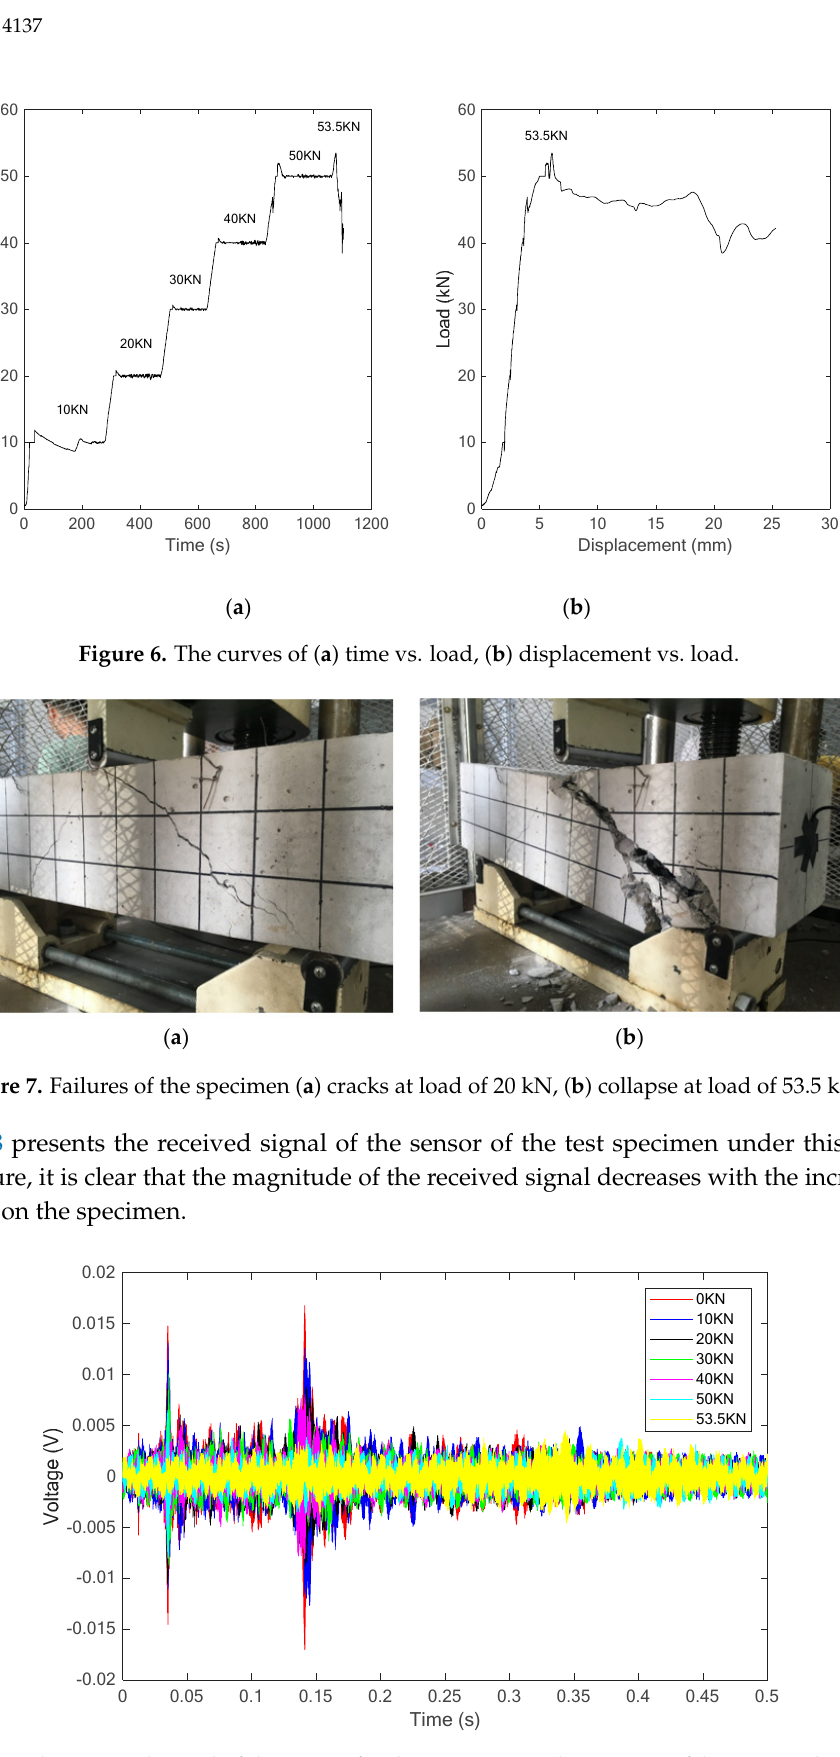
Figure 8. The received signal of the sensor for the specimen without SCFRP fabric strengthening.